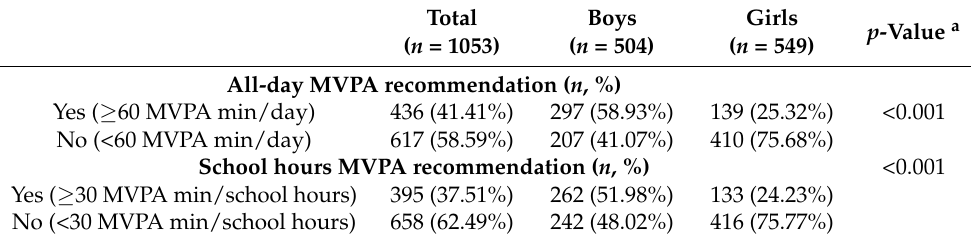
Table 3. The prevalence of objectively measured meeting MVPA